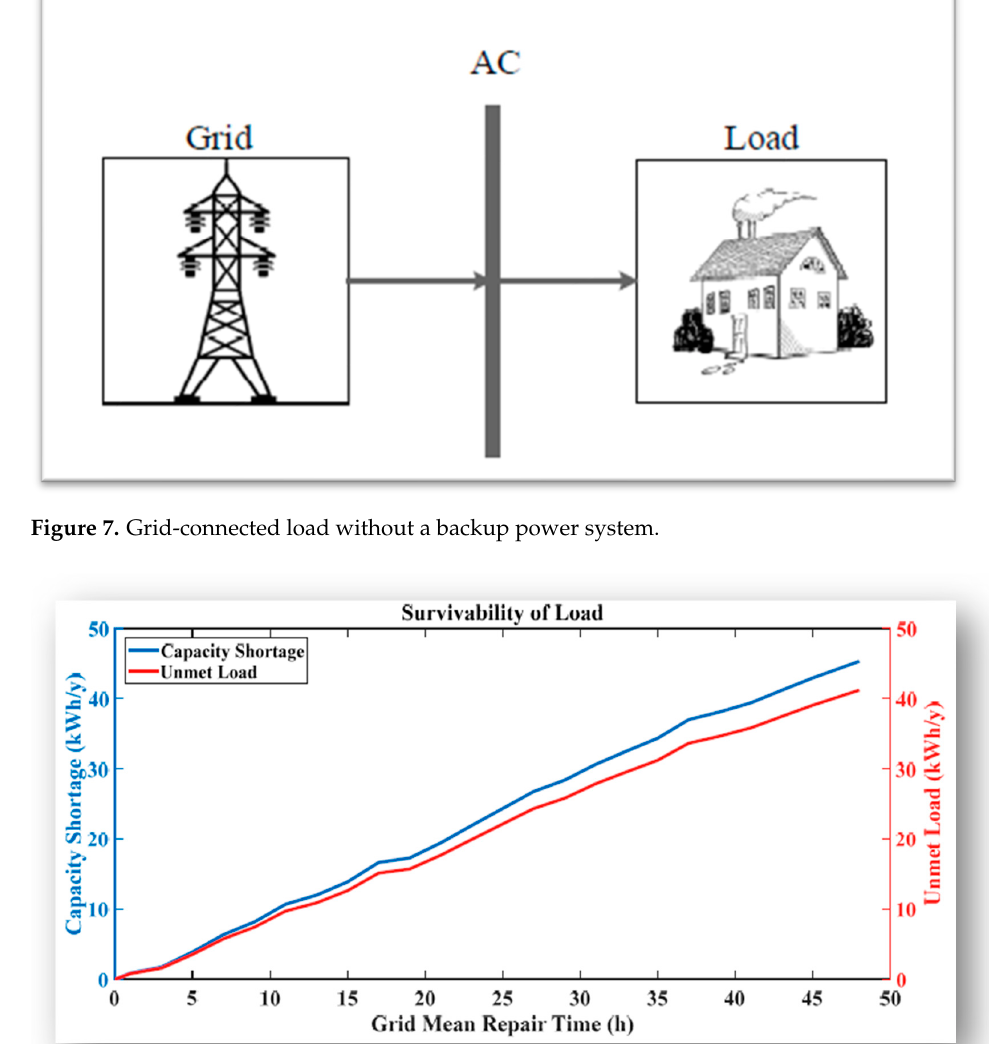
Table 5. Technical specification of the diesel generator (DG).